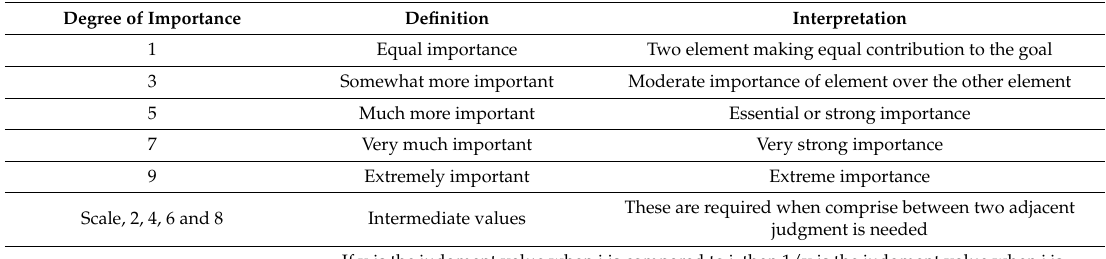
Table 3. Interpretation of ANP measurement scale (adapted from Saaty